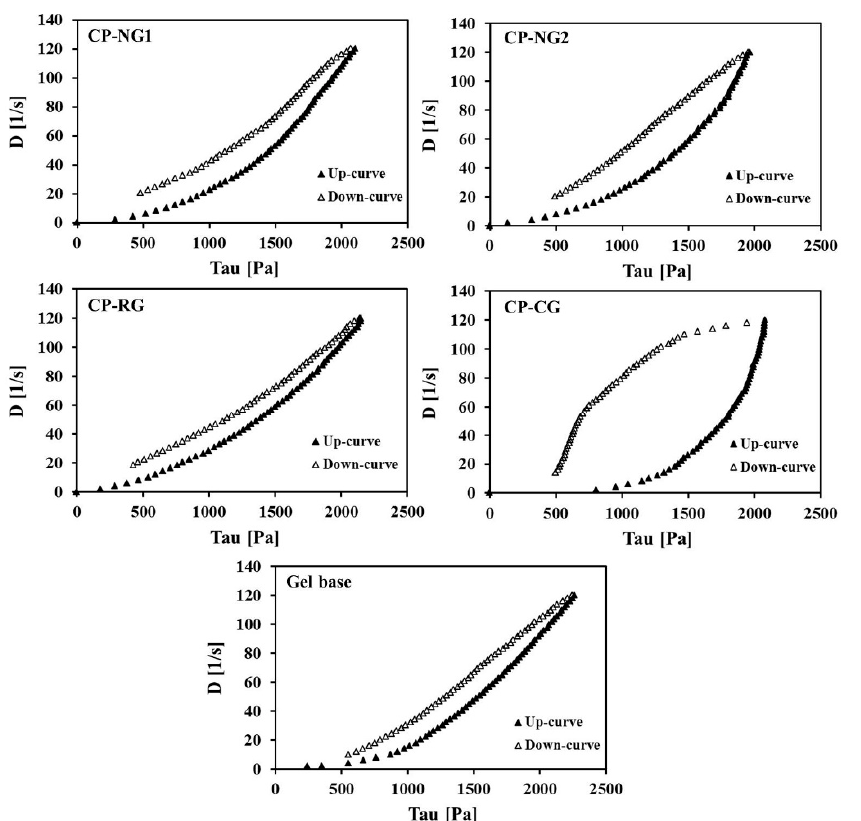
Figure 4. Rheograms of CP formulations and the gel base.